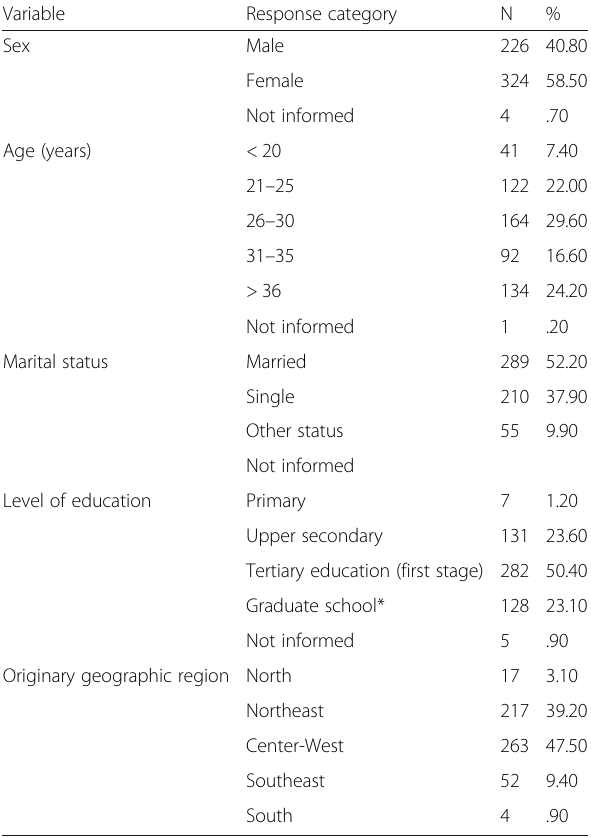
Table 1 Sociodemographic information of the participants ( N